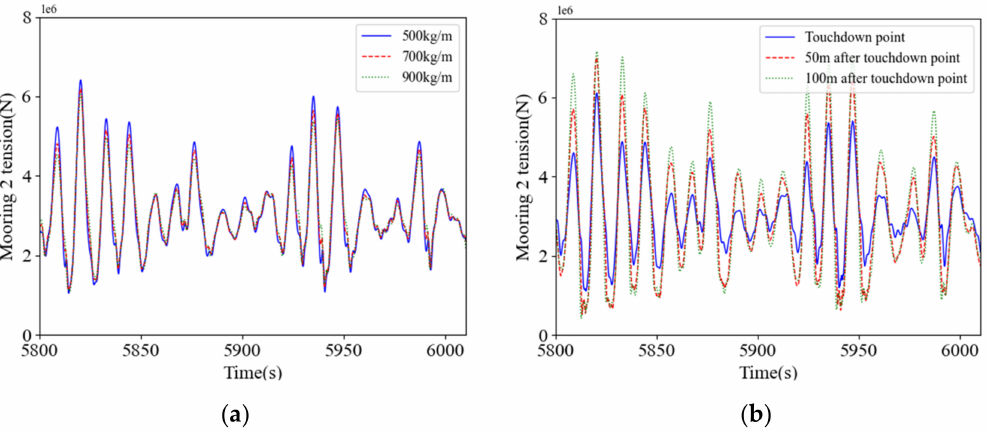
Figure 8. Comparison diagram of tension of No. 2 mooring line under different parameters of clump weight. ( a ) Different quality. ( b ) Different positions Heave.